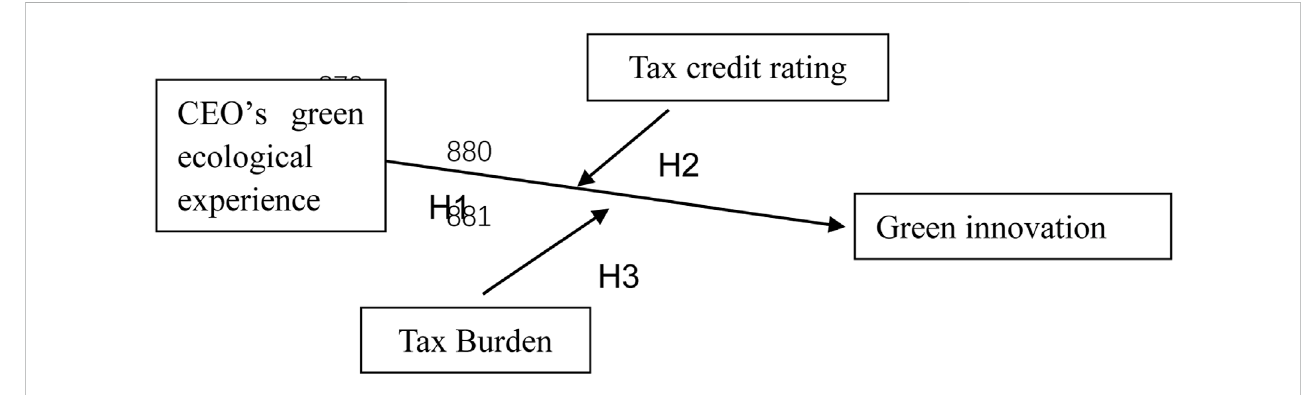
FIGURE 1 Research